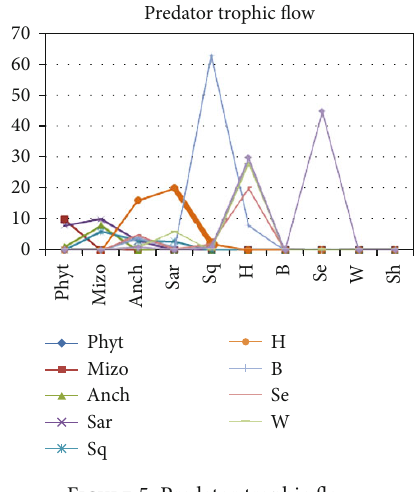
Figure 5: Predator trophic fl